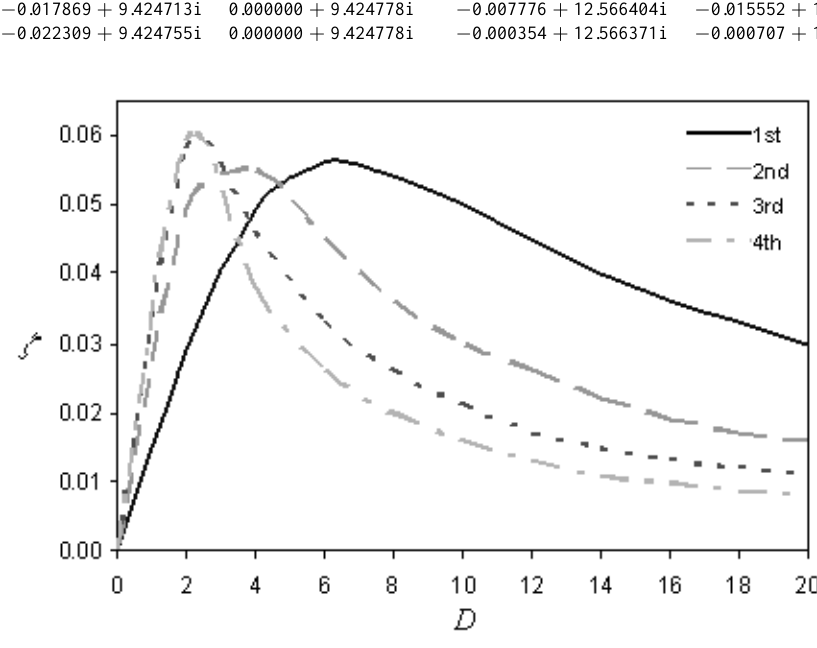
Fig. 5. Damping ratios versus dimensionless damping coefficient for the first four eigenfrequencies of locally reacting damping for a = 0.05. From Fig. 2, it can be seen that for the locally reacting damping and for the symmetrically located viscous dampers, the change of damping ratio with respect to the damper location for the first four eigenfrequencies are very similar to first four mode shapes of the undamped system, which are shown in Fig. 4. In fact, if the absolute values of the first four mode shapes are plotted for only the left half of the undamped rod, then exactly the same shape curves shown in Fig. 2 will be evaluated. As a result, it is clear that the damping ratio for ith mode is linearly proportional to | U i ( a ) |